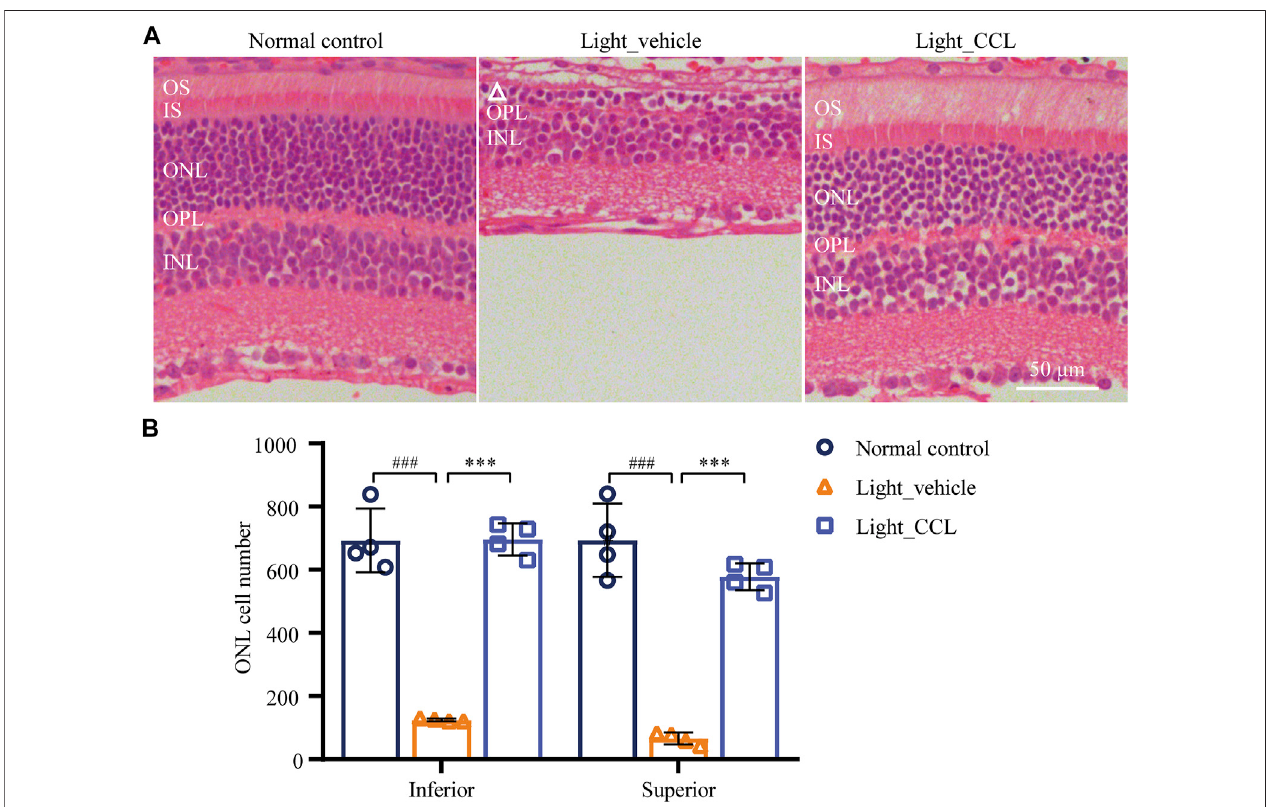
FIGURE 4 | CCL protects against light-induced morphological damage to the photoreceptors. Histological examination was performed by H&E staining. (A) Representative micrographs from the indicated experimental groups. (B) The number of photoreceptors was counted from ONH to 400 μ m off ONH in the inferior and superior retinas. White triangle signi fi es the damage ONL. INL, inner nuclear layer; IS, inner segment; ONH, optic nerve head; ONL, outer nuclear layer; OPL, outer plexiform layer; OS, outer segment. Scale bar, 50 μ m. The data were expressed as mean ± SD (n = 4 per group). ### Compared to Normal control, p < 0.001; *** compared to Light_vehicle, p <